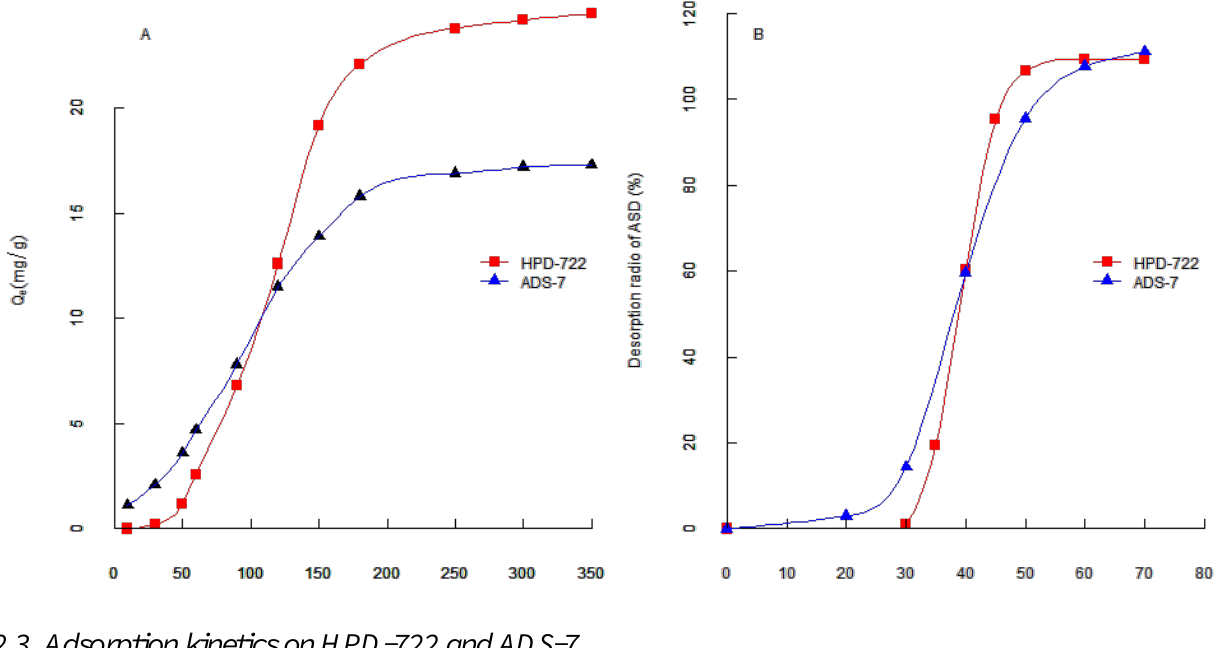
Figure 3. ( A ) Adsorption kinetics curves for ASD on HPD-722 and ADS-7 resins; ( B ) Dynamic desorption tests of ASD on HPD-722 and ADS-7